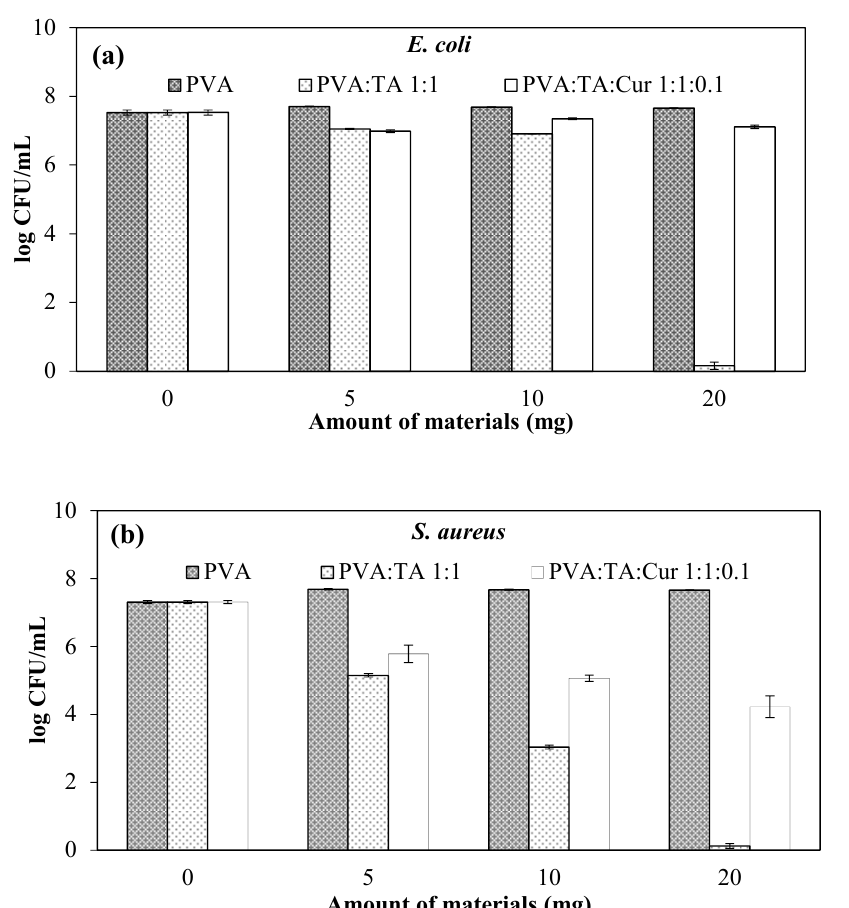
Figure 6. Bacterial growth number (log colony forming unit ((CFU)/mL)) in nutrient broth in the presence of PVA:TA:Cur 1:1:0.1 cryogel composites for ( a ) Gram-negative E. coli and ( b ) Gram-positive S. aureus .